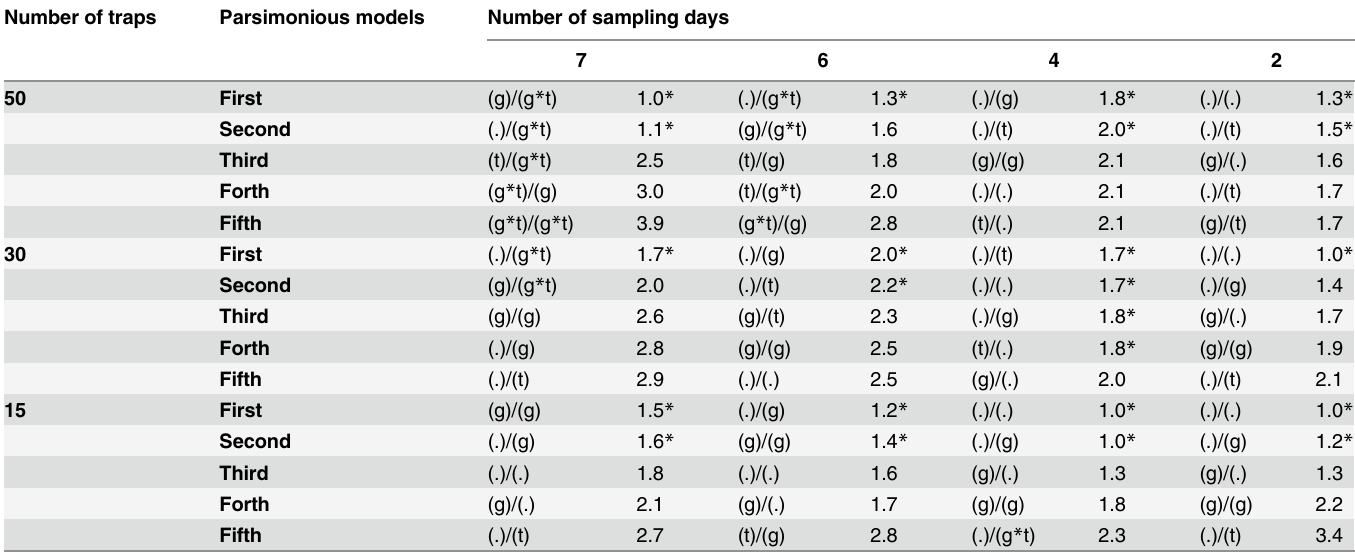
Table 3. Dependency of survival probability (Phi) and recapture probability (p) on sex (g), time (t) and/or sex and time (g * t) in the five top models for combinations of sampling days and number of traps. General model is Phi(x)p(y) where “ x ” and “ y ” have been shown in the following table as (x)/(y). Number of traps Parsimonious